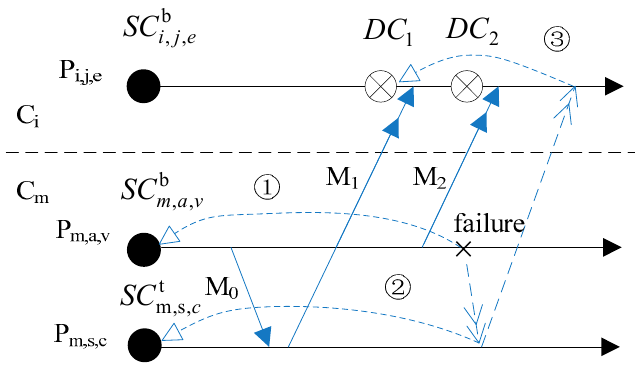
Figure 6. Example of DC taking.